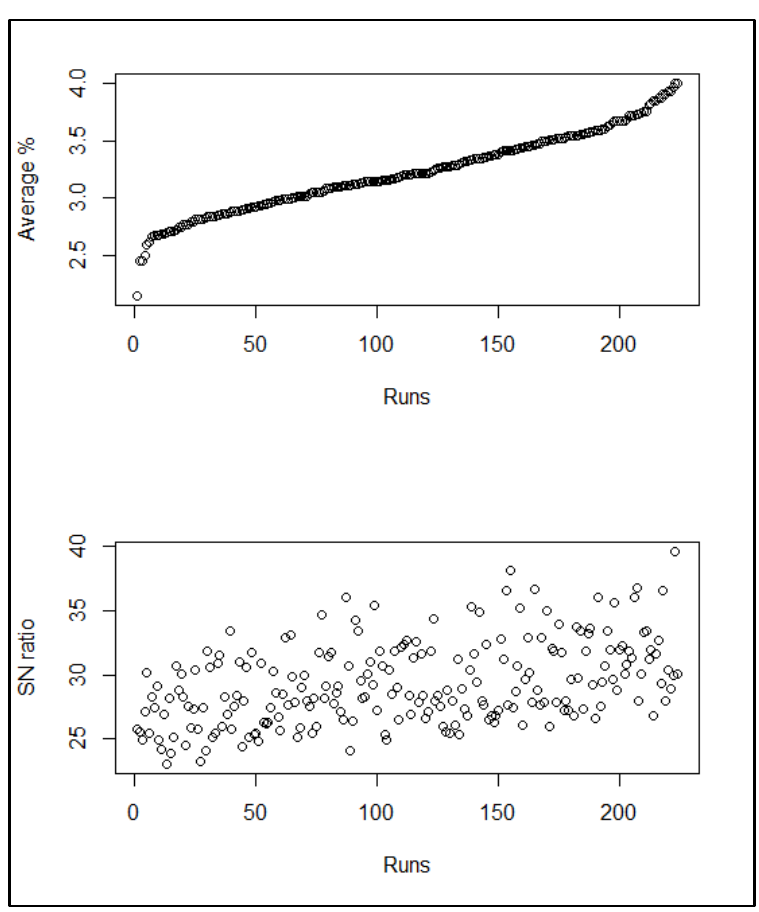
Figure 8. The effect of factors’ levels on the variability (SPP). Table 8. Possible runs with an average of 3.21% for